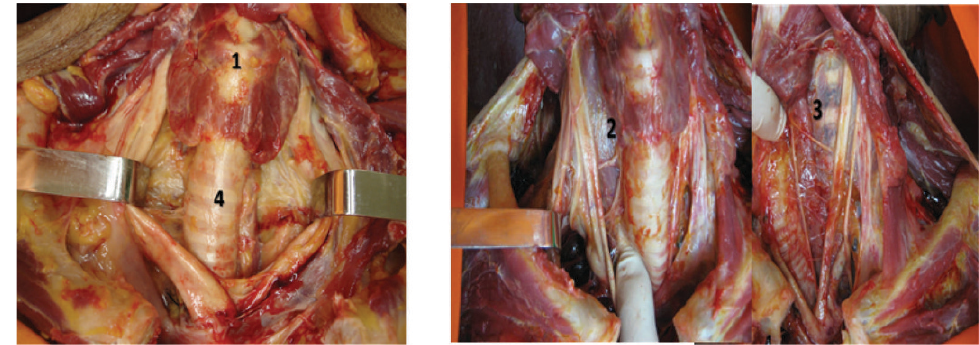
Figure 1 - Sublevels of the central compartment of the neck. Spaces of the central compartment of the neck: prelaryngeal (1); lateral to the recurrent laryngeal nerves on the right (2) and left (3) sides; pretracheal, between the recurrent laryngeal nerves